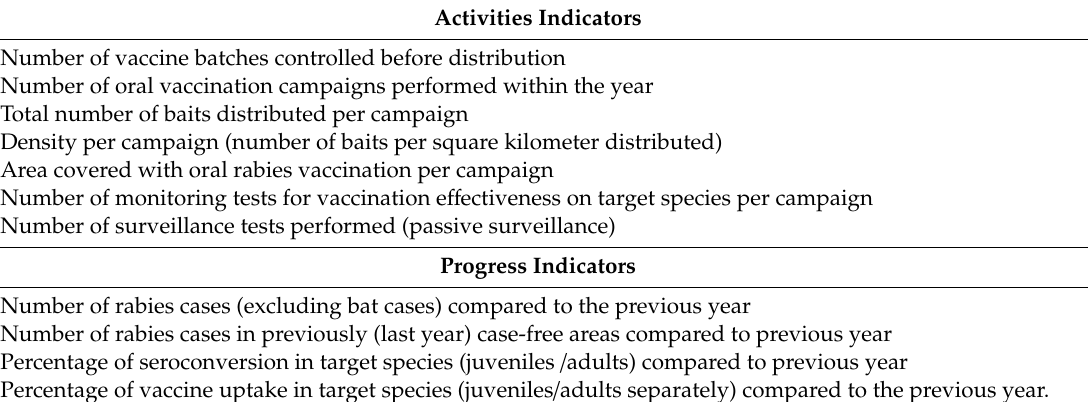
Table 1. Indicators for the evaluation of rabies eradication, control and surveillance programs. Activities